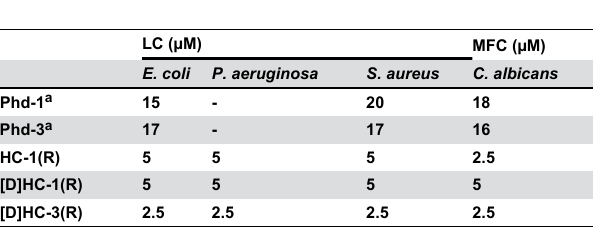
Table 2. Antimicrobial activity of HBD-1 and-3 analogs.